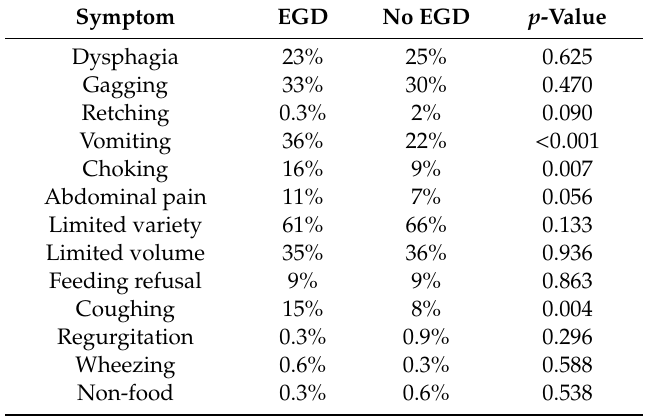
Table 1. Symptom frequencies of patients with an EGD vs. those without an EGD. Symptom EGD No EGD p